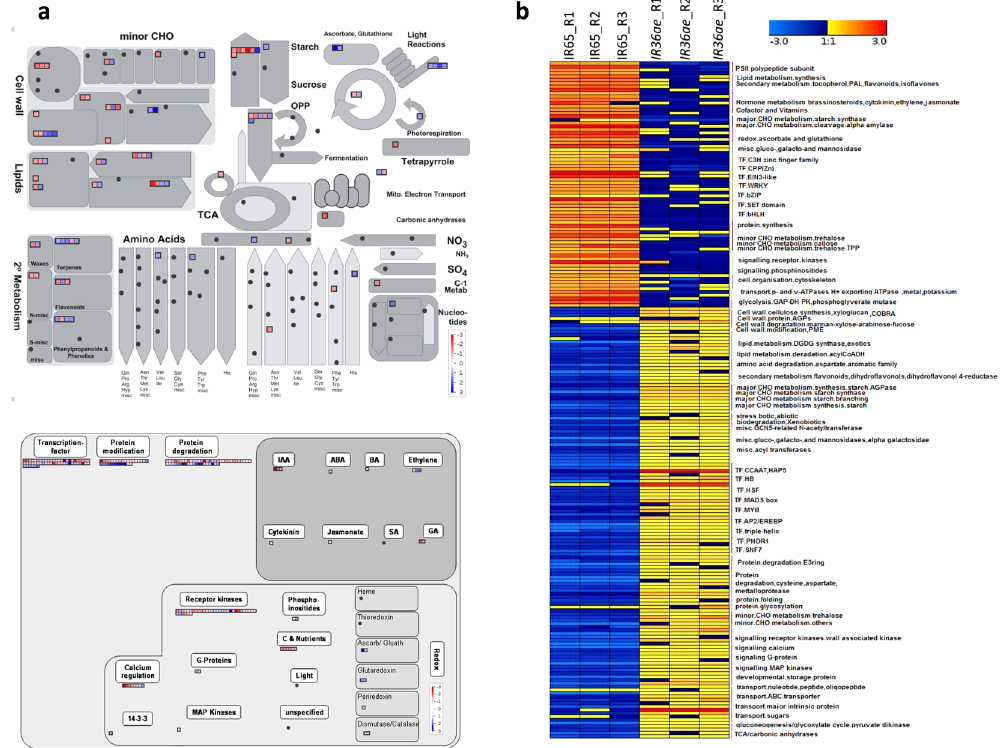
Figure 5. Transcriptomics analysis of low vs. high GI lines. ( a ) MapMan overview of differences in metabolites between low and high glycemic index varieties and ( b ) heatmap showing differentially expressed